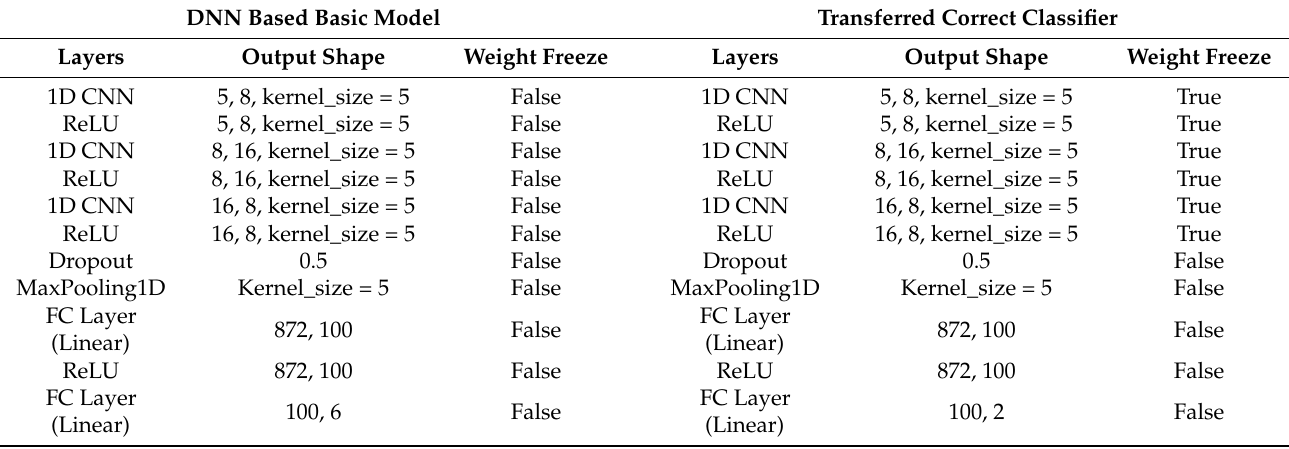
Table 7. Convolution neural networks based basic